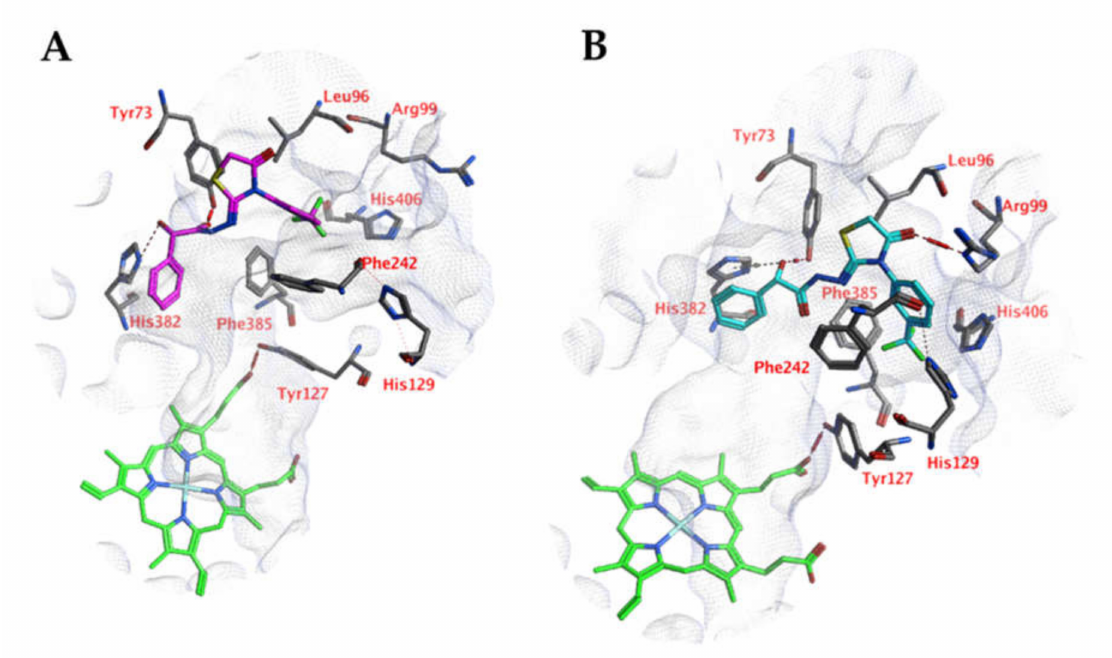
Figure 2. ( A ) The docked pose of compound 4o (turquoise) in the active site of CgCYP51 (PDB: 5jlc). ( B ) The docked pose of compound 4o (purple) in the active site of CgCYP51 after a 5-ns molecular dynamics simulation. The haem group is indicated in green sticks. The pocket surface is indicated with a white mesh. hydrogen bonds are indicated in red dashed lines. h-arene interactions are indicated in yellow dashed